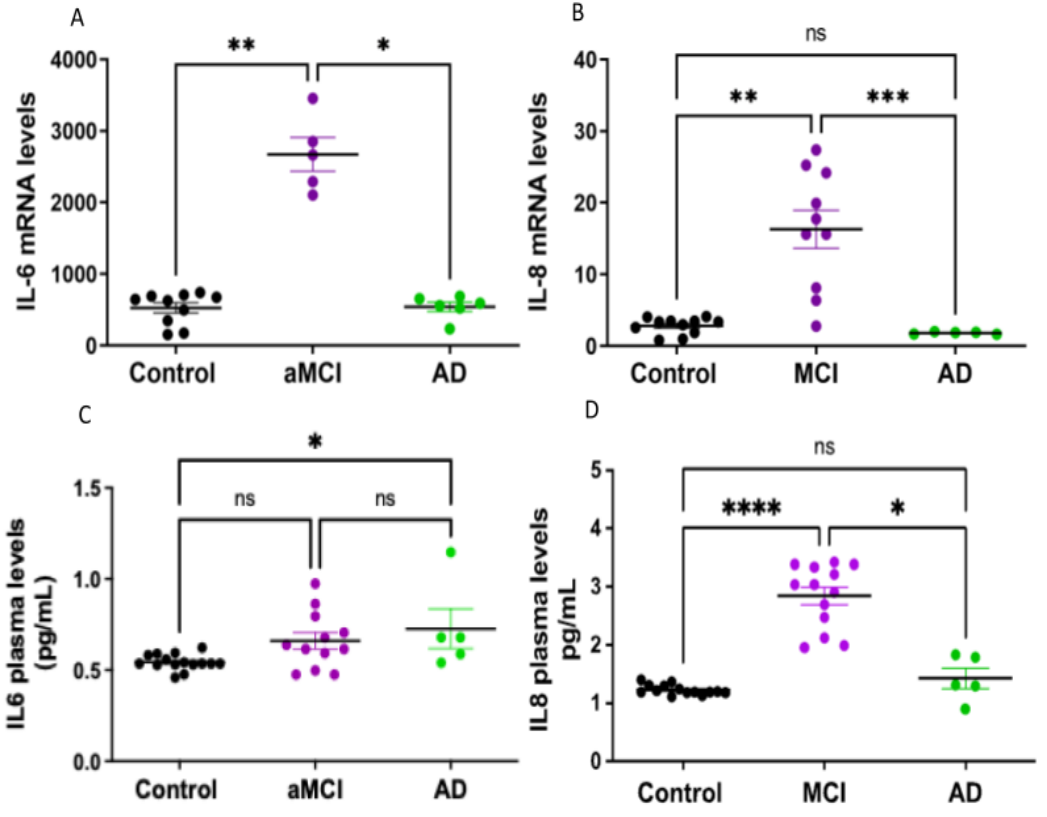
Figure 5. IL-6 and IL-8 expressions were increased in aMCI patients. ( A , B ): mRNA expression levels of cytokines IL-6 ( A ) and IL-8 ( B ) determined by qPCR in PBMCs of healthy controls, aMCI and AD patients. Both cytokines were increased in PBMCs of aMCI patients, whereas in AD, the levels were the same as in healthy controls. n= 19 healthy controls, 15 aMCI and 6 AD patients for IL6 and 11 healthy controls, 10 aMCI and 5 AD patients for IL8. ( C , D ): Plasmatic levels of IL-6 ( C ) and IL-8 ( D ) were measured by ELISA. IL-8 levels were significantly increased in aMCI compared with healthy controls and AD. There was a subtle increase in IL-6 plasmatic levels in AD, but the number of AD patients was small, and the values were too dispersed to be conclusive; n = 15 controls, 12 aMCI and 5 AD patients for IL-6 and 14 controls, 13 aMCI and 5 AD patients for IL-8. Statistical analysis: Kruskal–Wallis with Dunn’s post hoc correction. * p < 0.05, ** p < 0.01 *** p < 0.005, **** p < 0.0001, ns = non-significant.